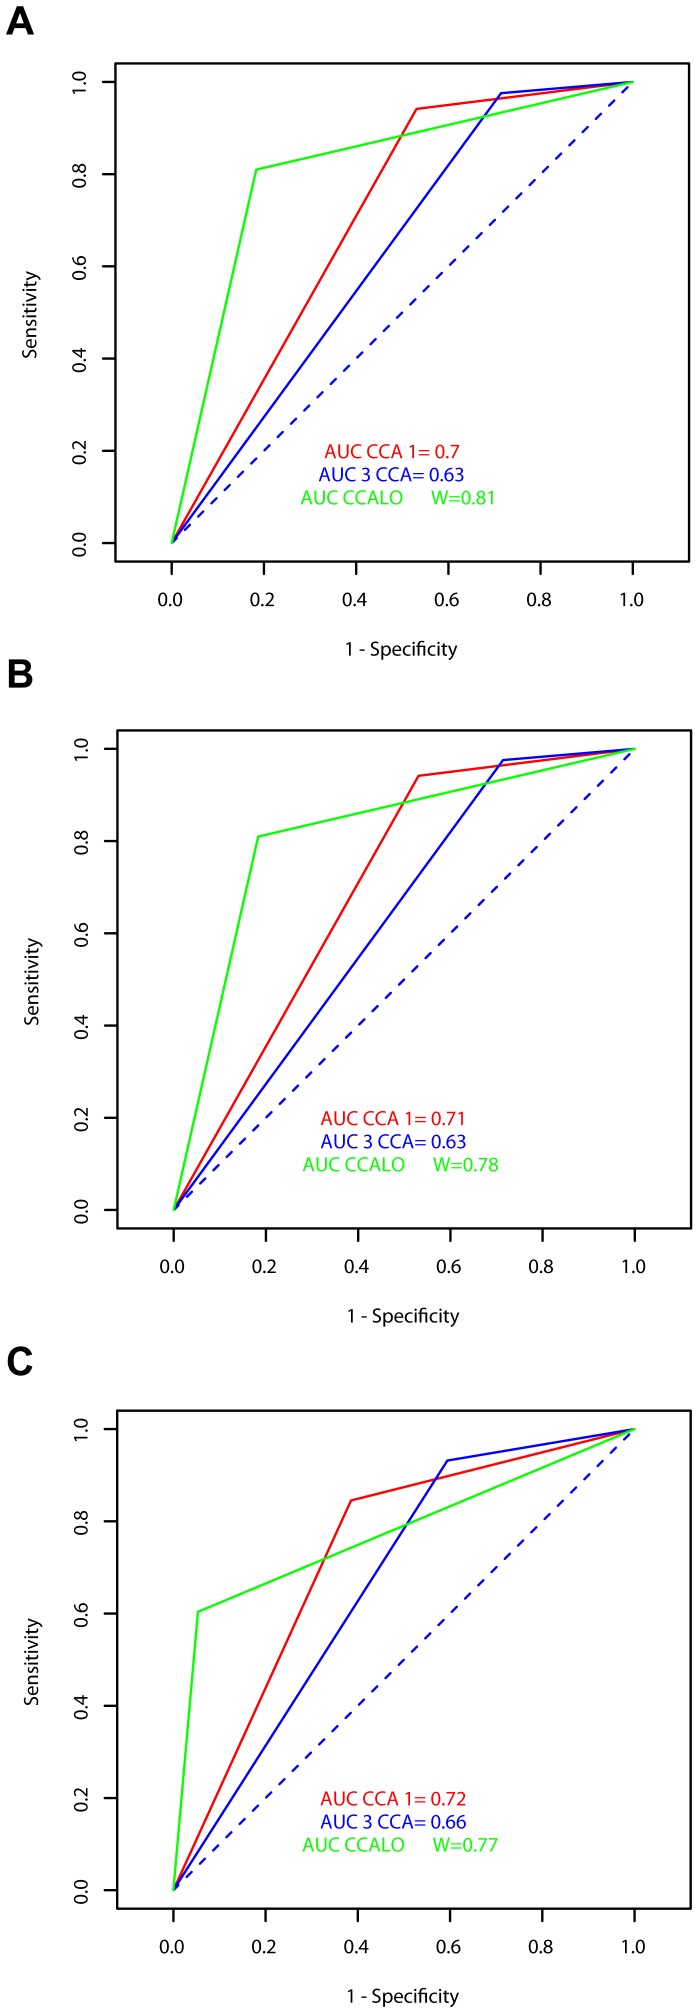
ROC curves and AUC of CCA results using Kato-Katz as reference tests.The receiver operating characteristic (ROC) curves and the area under the curve (AUC) of CCA and CCA-L are presented using either single (A), triplicate (B) and nine Kato-Katz (C) thick smears as the reference tests. The discriminating powers of single CCA and CCA-L were high in all cases.